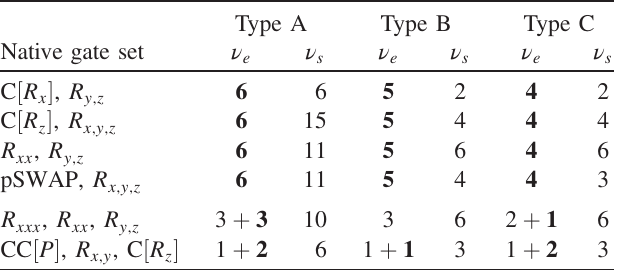
TABLE I. Number ν e of entangling gates with 2-(3-)qubit gates in bold (roman) and number ν s of single-qubit gates when recompiling elementary controlled- SWAP operations: fully equiv- alent (type A), local SU(4) equivalent recompilation (type B), and recompilation with including the observable σ (type C). R α denote single-qubit rotation gates with α ∈ f x; y; z g , while C ½ R α (cid:2) denote controlled rotations. R xx denotes the xx gate and